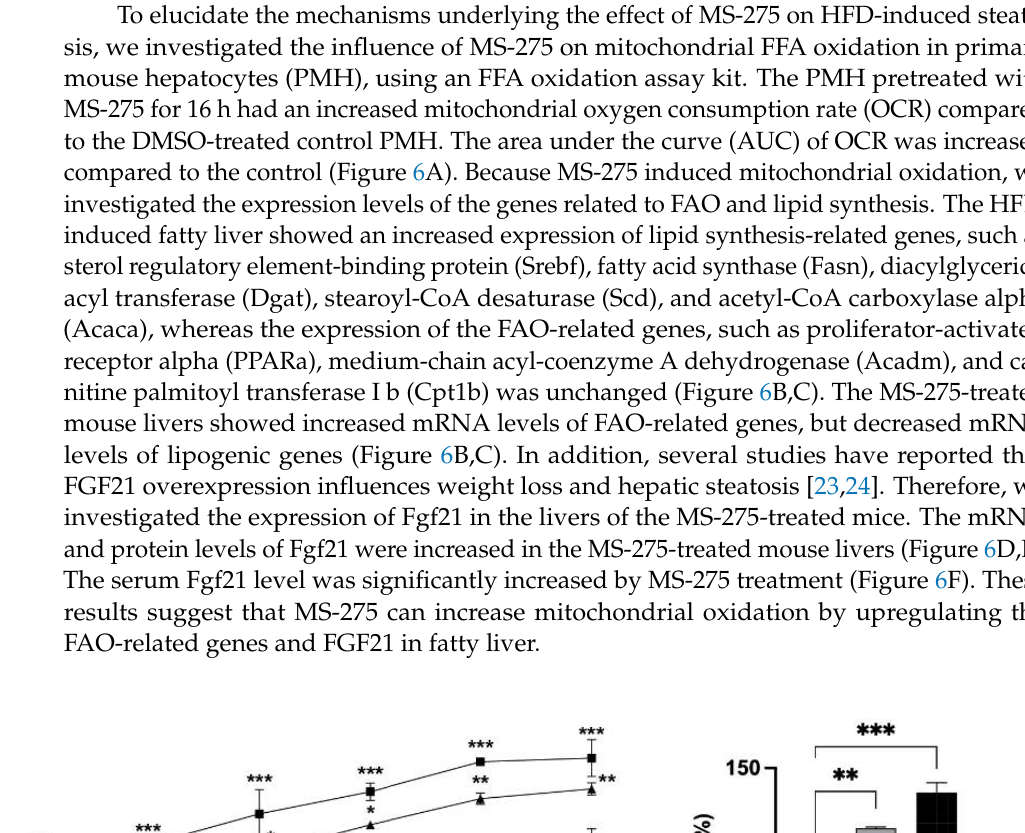
Figure 6. MS-275 increased mitochondrial oxidation in mouse primary hepatocytes, and the expres- sion of FGF21 in HFD-induced fatty liver. ( A ) Mouse primary hepatocytes were isolated from 8- week-old C57BL/6J mice. Mitochondrial respiration in mouse primary hepatocytes exposed to 1 or 3 µM MS-275 was investigated by measuring the mitochondrial oxygen consumption rate (OCR); ( B , C ) mRNA expression levels of FAO-related genes (PPAR α , Acadm, Cpt1b, and Ucp1) and lipid synthesis-related genes (Fasn, Dgat, Scd, Acaca, Srebp1c) in liver tissue injected with MS-275 were